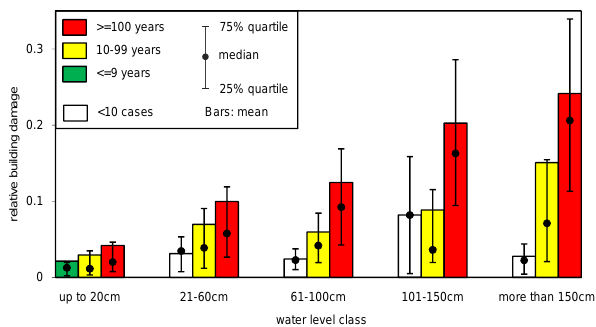
Fig. 4. Comparison of average building loss ratios per water level and recurrence interval